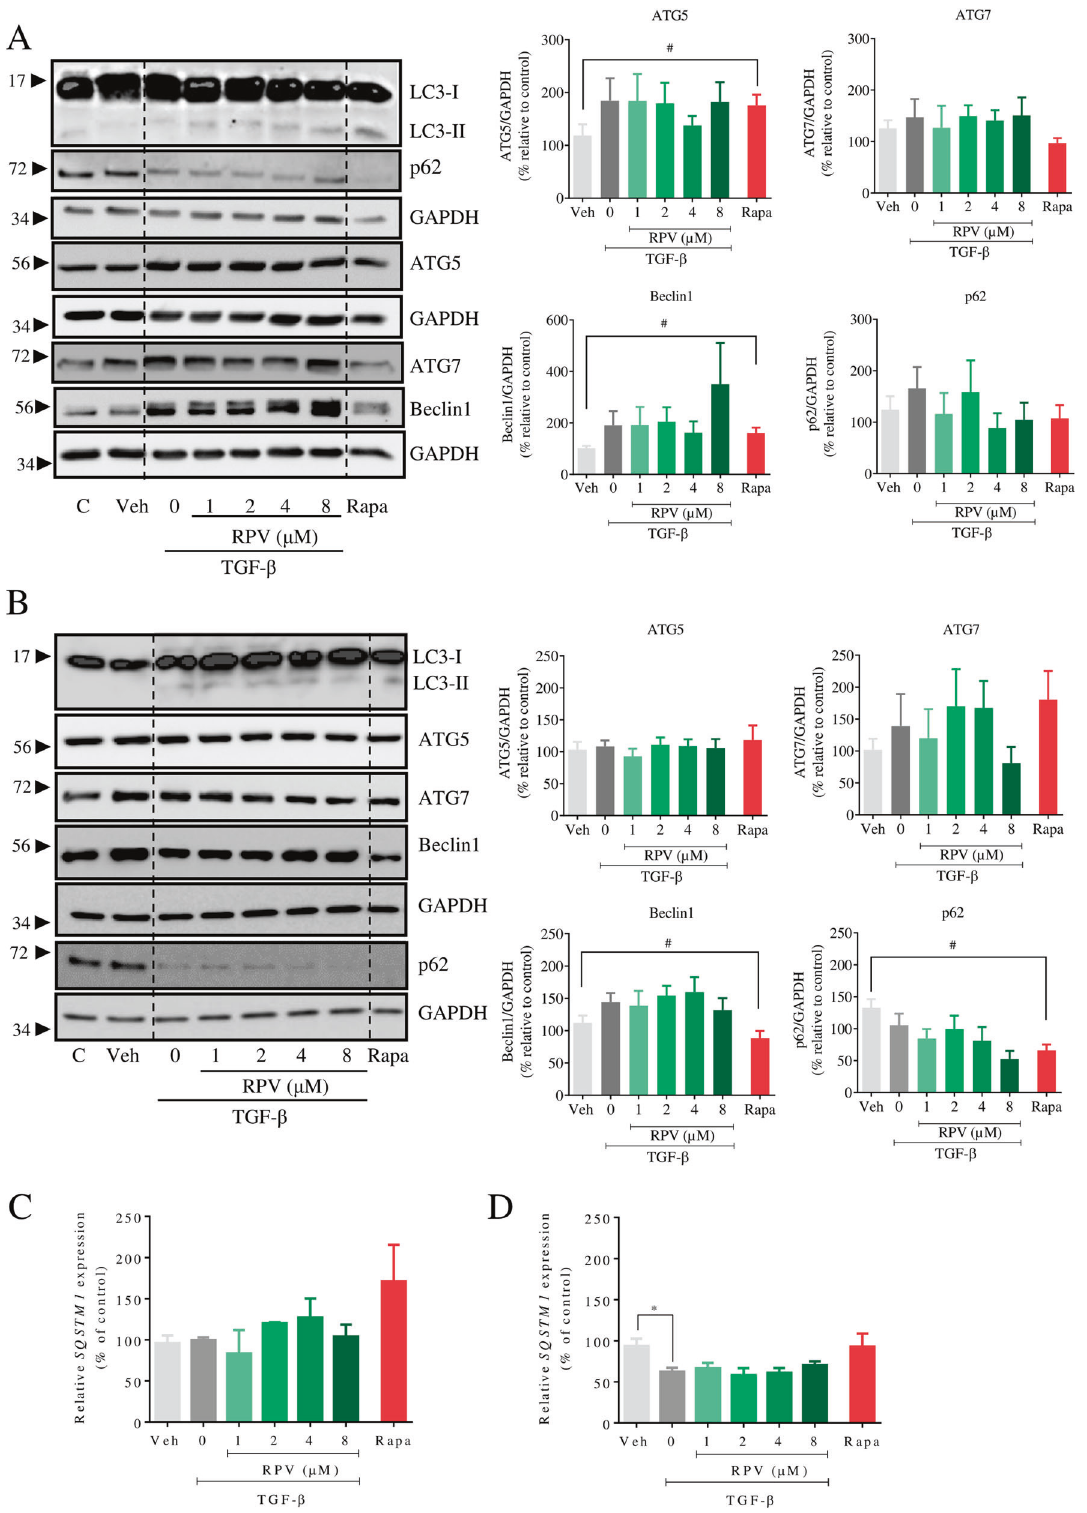
Fig. 3 Analysis of autophagic markers in activated LX-2 cells treated with RPV. LX-2 cells were exposed to vehicle, TGF- β or TGF- β plus RPV (1, 2, 4, and 8 µM) for 24 h or 48 h. Representative images of immunoblots for LC3, p62, ATG5, ATG7, and Beclin-1 using whole cell protein extracts of cells treated for 24 h ( A ) and 48 h ( B ) and summary of densitometry data of treatments. Expression was normalized with that of GAPDH as a reference protein. Relative gene expression of SQSTM1 (p62) obtained by RT-qPCR of cells treated for 24 h ( C ) and 48 h ( D ). Data which represent mean ± SEM ( n = 3 – 6) are expressed in relation to those of untreated cells in each experiment, which was considered 100%. Statistical analysis was performed with one-way ANOVA with Bonferroni post-test for RPV + TGF- β versus TGF- β treatment or with paired Student´s t test for TGF- β vs Vehicle (* represents p value < 0.05) and Rapamycin (Rapa) vs Vehicle ( # represents p value <